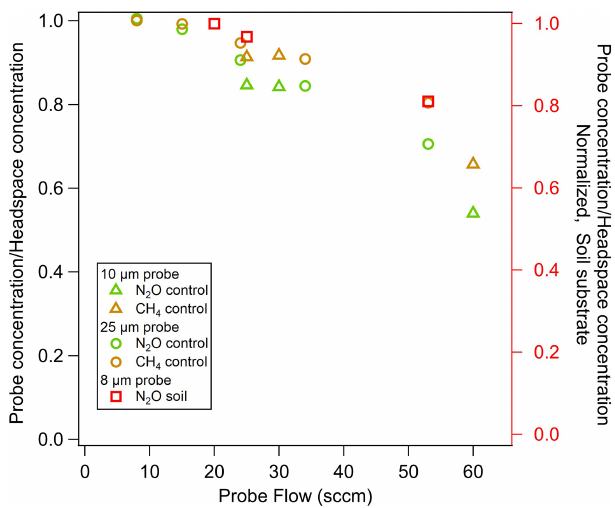
Figure 11. Impact of the probe sampling flow rate, pore size, trace gas species, and soil matrix on the fractional recovery of true soil gas concentrations with probes. Fractional recovery of N 2 O (green) and CH 4 (yellow) in a silica matrix with flowing control gas and a probe pore size of 10µm (triangle) and 25µm (circles). The re- covery of N 2 O gas in soil at the field moisture level (red squares), normalized to high recovery, measured with a probe pore size of 8µm. All measurements using System